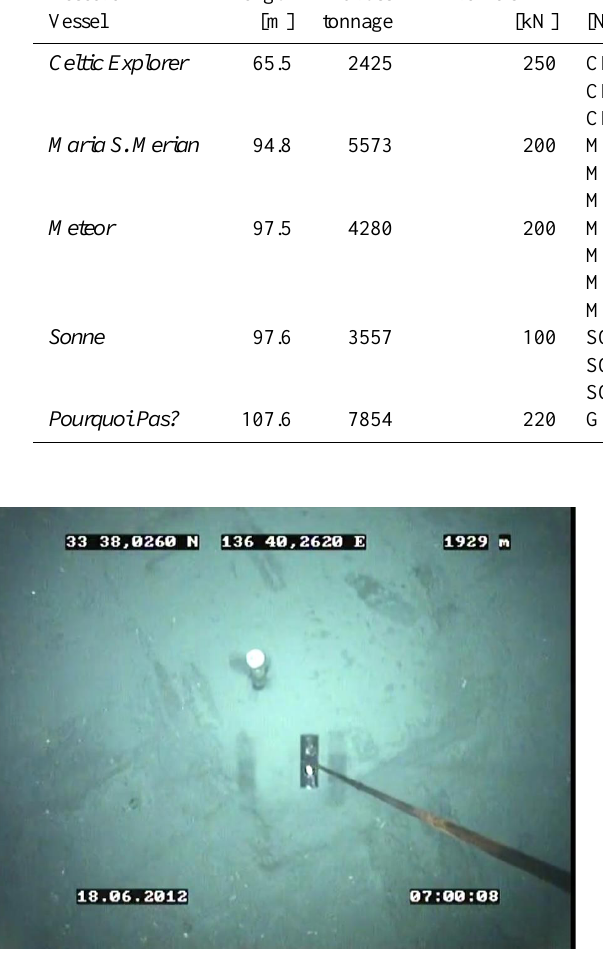
Fig. 8. Picture of a MeBo-CORK installed in June 2012 with the Figure 8. Picture of a MeBo-CORK installed in June 2012 with MeBo. The picture was taken 3 MeBo. The picture was taken a few days after installation with a a few days after installation with a towed camera sled, the Ocean Floor Observation System 4 towed camera sled, the Ocean Floor Observation System (OFOS) (OFOS) of the research vessel SONNE. Note the imprint of the base frame and of the legs of 5 of the research vessel Sonne . Note the imprint of the base frame and the MeBo on the sea floor. The distance weight on a 2 m rope at the lower right of the picture 6 of the legs of the MeBo on the sea floor. The distance weight on belongs to the camera sled and assists the winch driver in assessing distance to sea floor 7 a 2m rope in the lower right of the picture belongs to the camera (Photo: Marum). 8 sled and assists the winch driver in assessing distance to sea floor (photo: